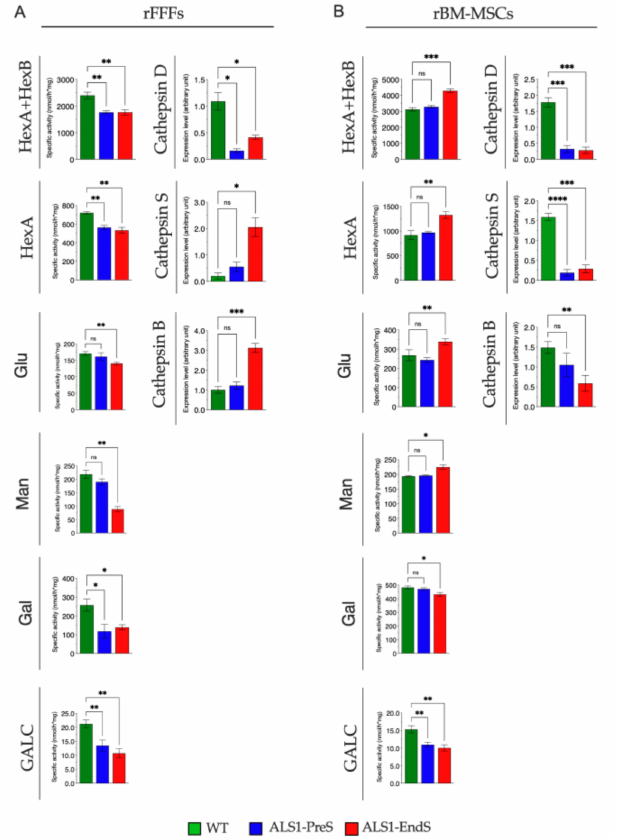
Figure 6. The activity of lysosomal glycohydrolases and expression levels of proteases in rFFFs ( A ) and rBM-MSCs ( B ) from ALS1 and WT rats. Levels of glycohydrolases were measured by using specific fluorogenic substrates (see Section 2.14 for details). Levels of proteases were determined by Western blotting (see also Figure S4B,C in Supplementary File). Shown are the densitometry analyses of all experiments. Results are expressed as the mean ± SD of three independent experiments, each in triplicates. ns, not significant, * p < 0.05, ** p < 0.01, *** p < 0.001, **** p <